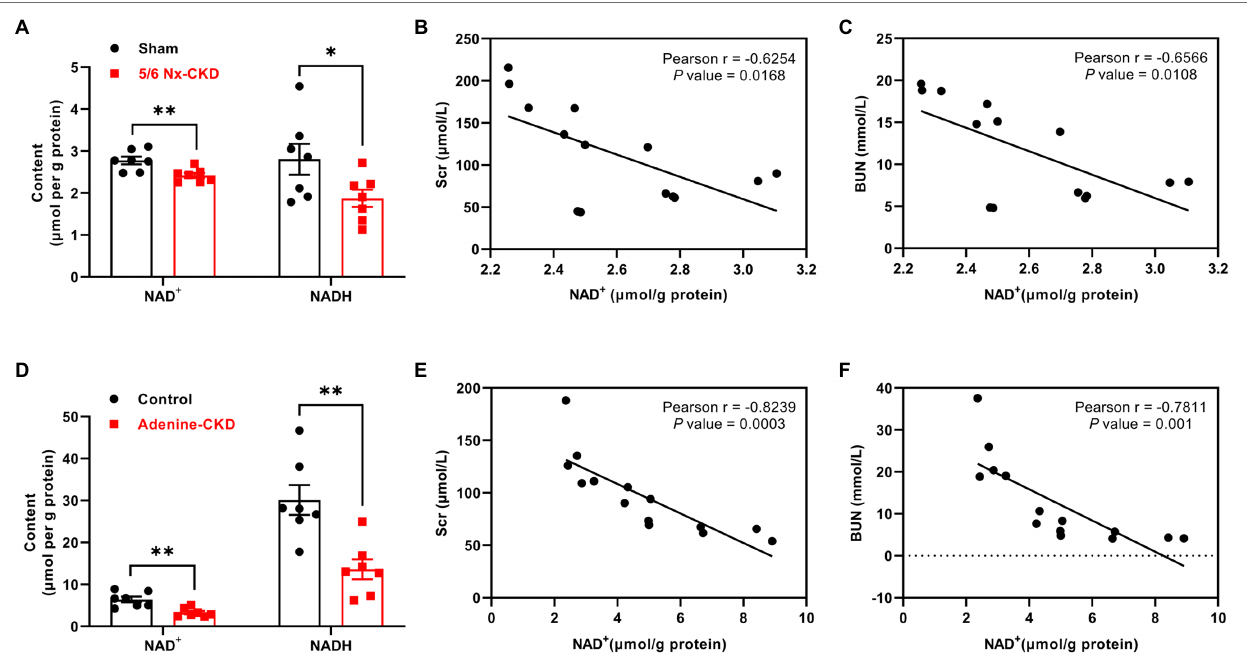
FIGURE 3 | The content of NAD + and NADH in the kidney and the correlation analysis between NAD + levels and renal function indexes. (A) The content of NAD + and NADH in the kidney of sham and 5/6 Nx-induced CKD rats. (B) The correlation between NAD + and Scr in Experimental Part I ( n = 14). (C) The correlation between NAD + and BUN in Experimental Part I ( n = 14). (D) The content of NAD + and NADH in the kidney of control and adenine-induced CKD rats. (E) The correlation between NAD + and Scr in Experimental Part II ( n = 14). (F) The correlation between NAD + and BUN in Experimental Part II ( n = 14). In (A) and (D) , data are presented as the means ± SEM, n = 7 rats per group ( * p < 0.05 and ** p < 0.01 between the indicated two